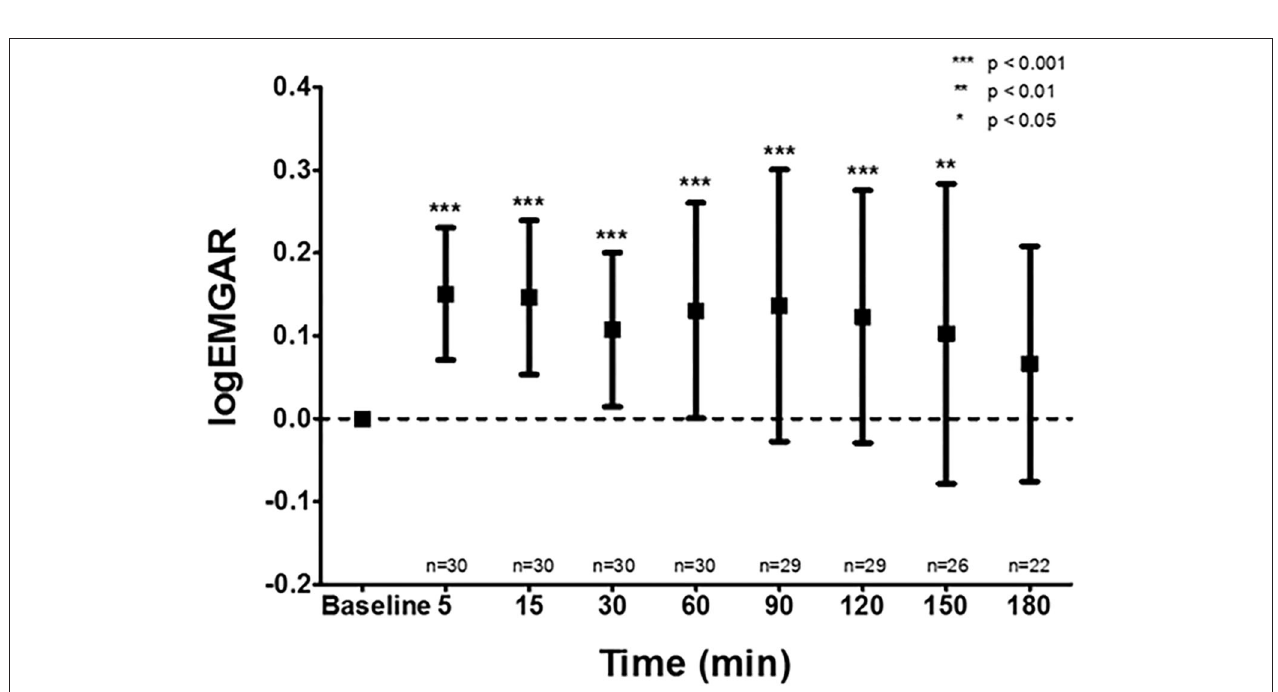
FIGURE 2 | Effect of caffeine on the amplitude of the diaphragm measured by electromyography. The transcutaneous electromyographic (EMG) analysis of the diaphragm showed a significant increase in logarithm of the EMG Activity Ratio (logEMGAR) after a loading dose caffeine, compared to baseline. The logEMGAR described the relative changes in EMG activity, either increasing or decreasing symmetrical around